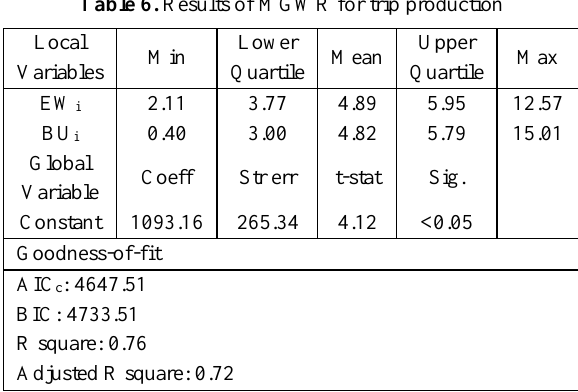
Table 7. Results of MGWR for trip